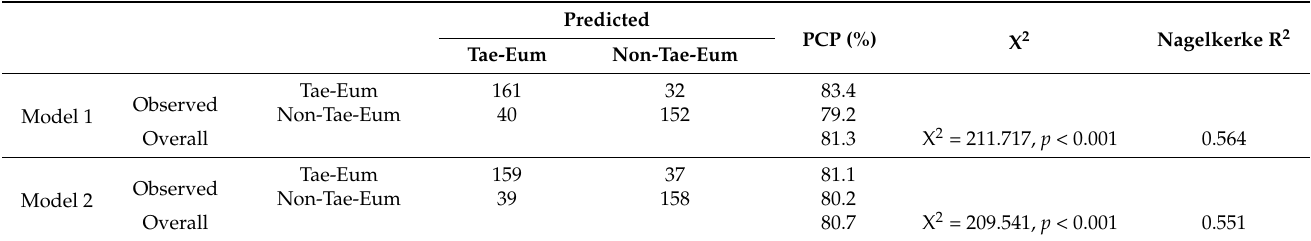
Table 5. Classification table and model summary of logistic regression analysis for discriminating Tae-Eum- and non-Tae-Eum-type